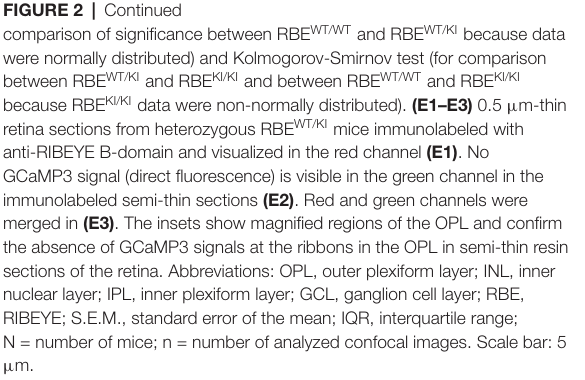
FIGURE 2 | Continued comparison of significance between RBE WT/WT and RBE WT/KI because data were normally distributed) and Kolmogorov-Smirnov test (for comparison between RBE WT/KI and RBE KI/KI and between RBE WT/WT and RBE KI/KI because RBE KI/KI data were non-normally distributed). (E1–E3) 0.5 µ m-thin retina sections from heterozygous RBE WT/KI mice immunolabeled with anti-RIBEYE B-domain and visualized in the red channel (E1) . No GCaMP3 signal (direct fluorescence) is visible in the green channel in the immunolabeled semi-thin sections (E2) . Red and green channels were merged in (E3) . The insets show magnified regions of the OPL and confirm the absence of GCaMP3 signals at the ribbons in the OPL in semi-thin resin sections of the retina. Abbreviations: OPL, outer plexiform layer; INL, inner nuclear layer; IPL, inner plexiform layer; GCL, ganglion cell layer; RBE, RIBEYE; S.E.M., standard error of the mean; IQR, interquartile